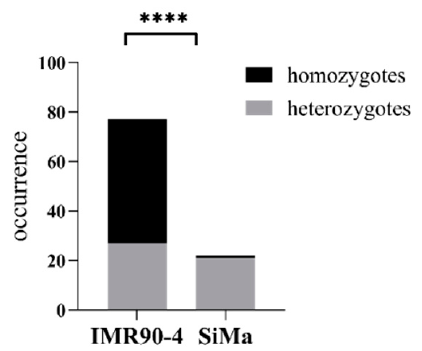
Figure 3. Donor DNA insertion success rate. Absolute occurrence of homozygous integration events vs. heterozygous integration events at the AAVS1 safe harbor locus. Frequency analysis measured by Χ 2 , **** = p > 0.0001.